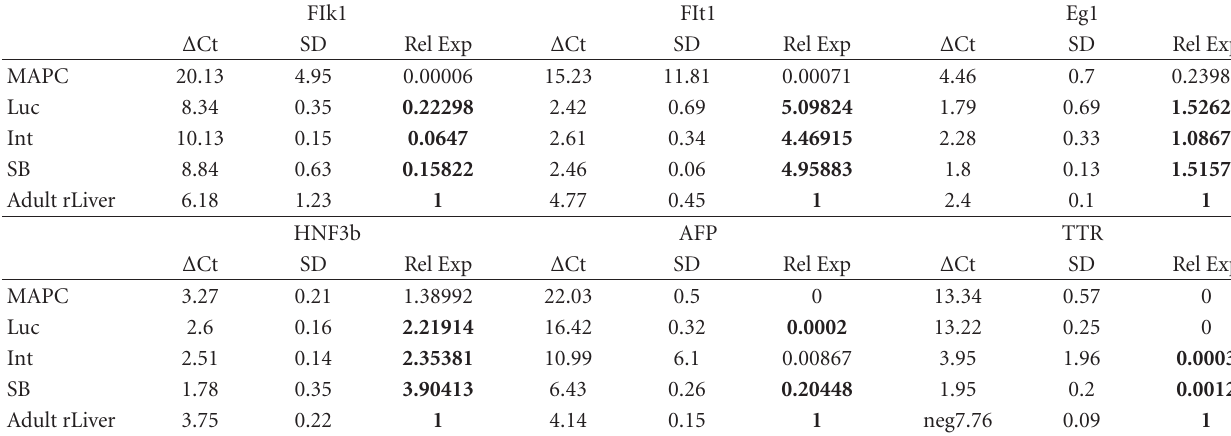
Table 1: qRTPCR analysis of di ff erentiated rMAPC. Endothelium markers Flk1, Flt1, and Eg1 and liver markers HNF3b, AFP, and TTR were measured and Ct values normalized to GAPDH levels to determine Δ Ct. Adult rat liver was used as the positive control and corresponding undi ff erentiated cells as negative control. Relative expression was carried out by determining Δ Ct values and comparing expression levels to the positive control sample.